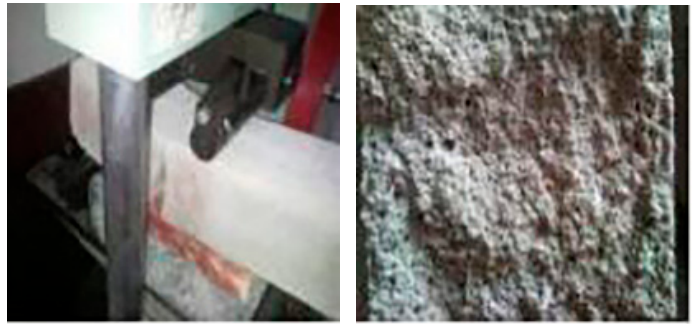
Figure 3. Failure modes of the specimens after the flexural test.